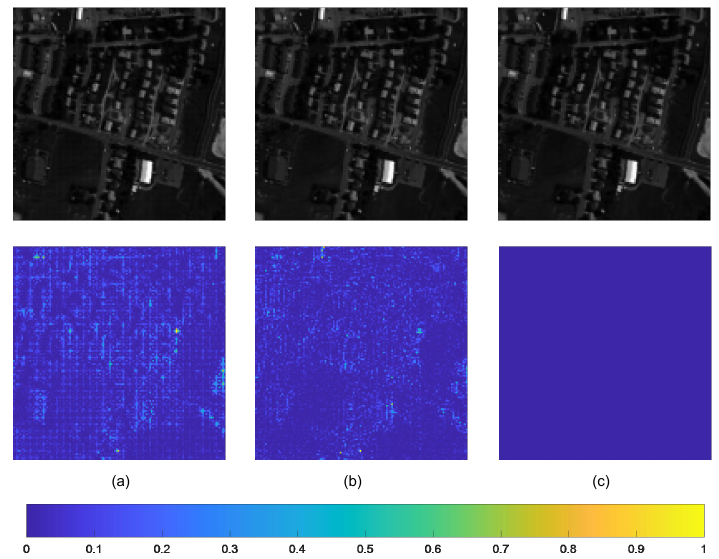
Figure 7. Reconstructed HR-HSI and its corresponding error image at the 15th band for Ubran. ( a ) HTSRWM method; ( b ) HTSR method; ( c ) Ground truth.